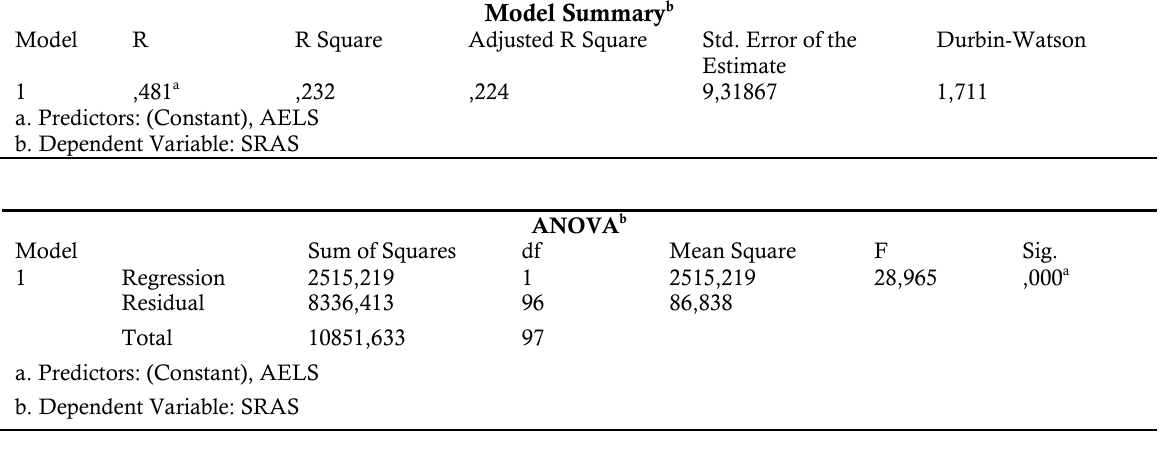
Table 3 Regression